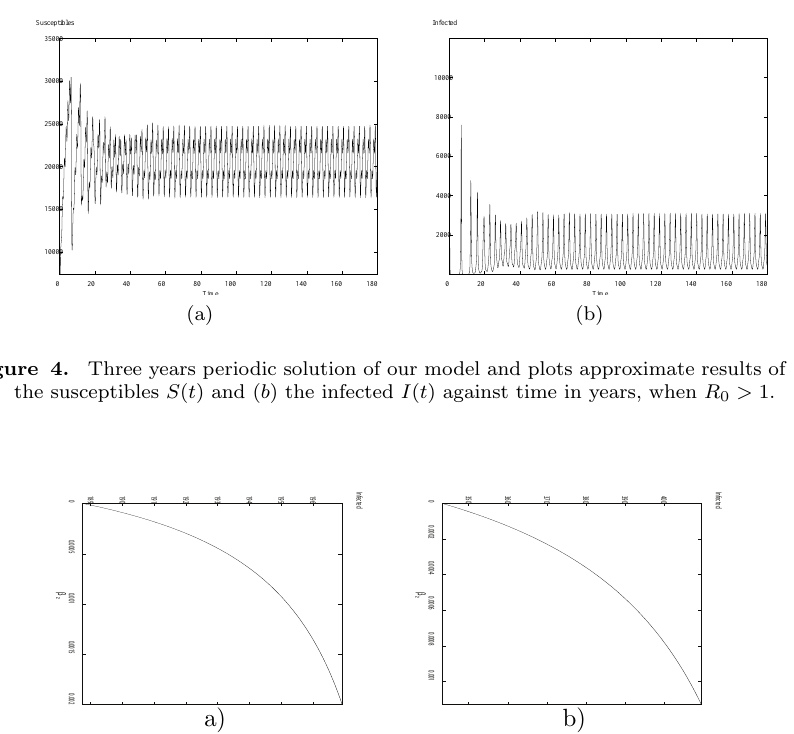
189190191192193194195196